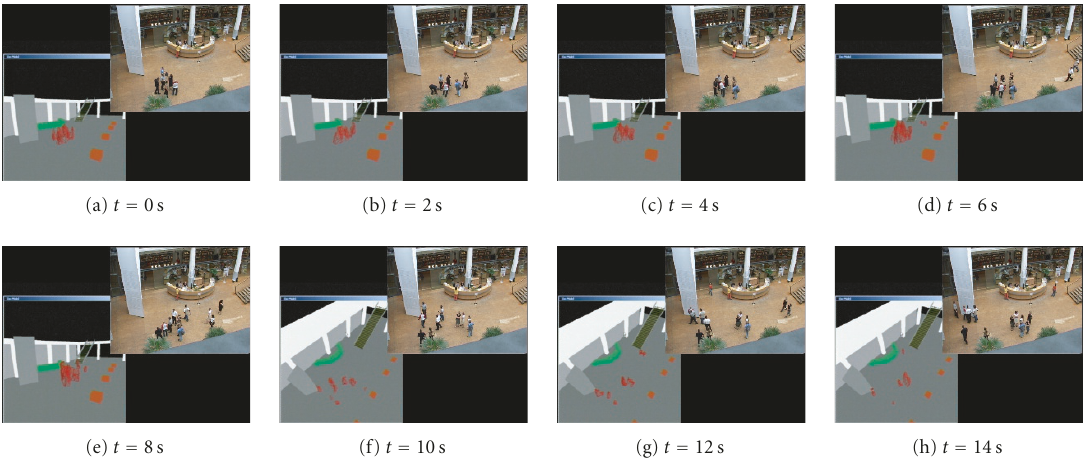
Figure 9: Real scenes and corresponding 3D models.